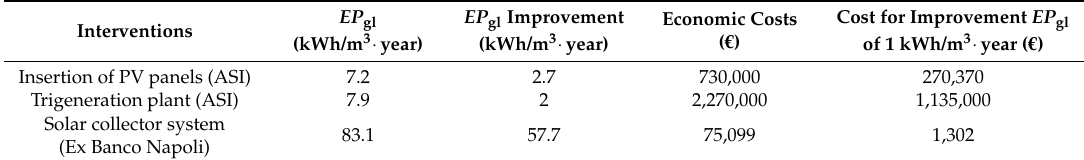
Table 13. Economic costs and EP gl improvement for each considered intervention in ASI and Ex Banco